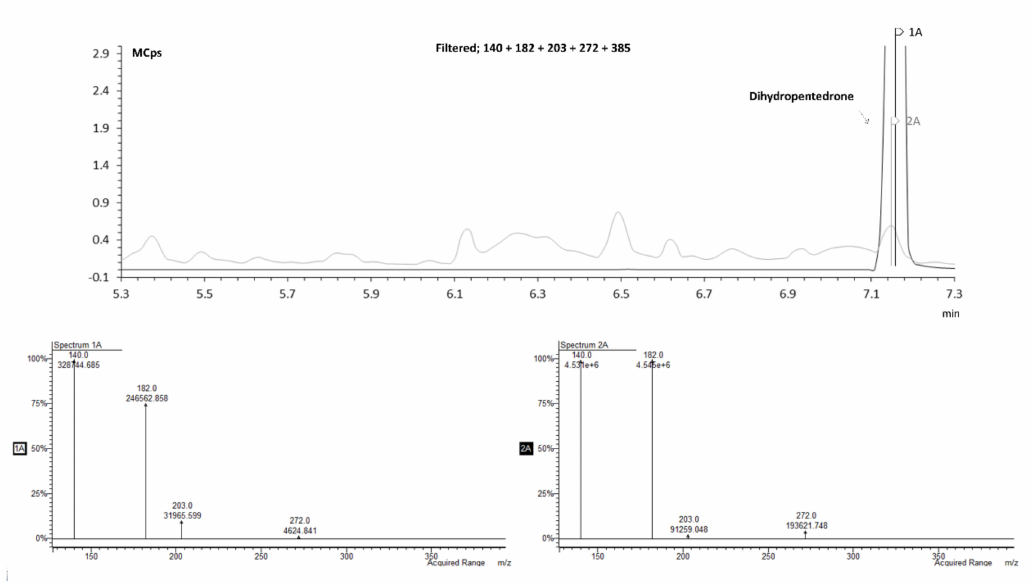
Figure 8. Overlapped zoomed GC–MS SIM mode chromatogram of an extracted sample of HLM incubated with S -(+)-pentedrone for 20 min (spectrum 1A) and dihydropentedrone (spectrum 2A).